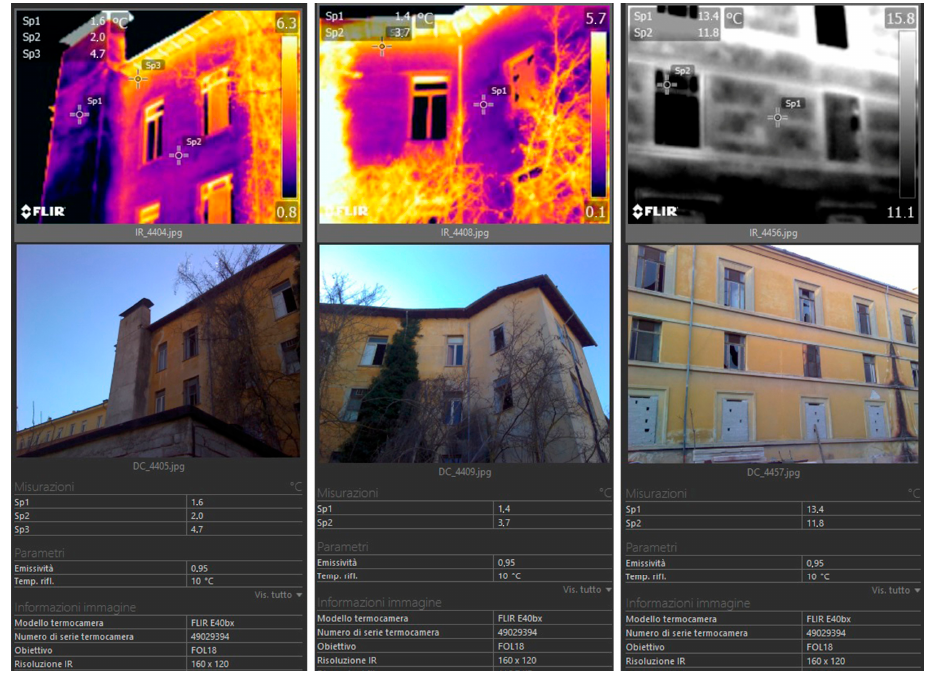
Figure 7. Thermographic survey: view of some elaborated thermal imaging data.